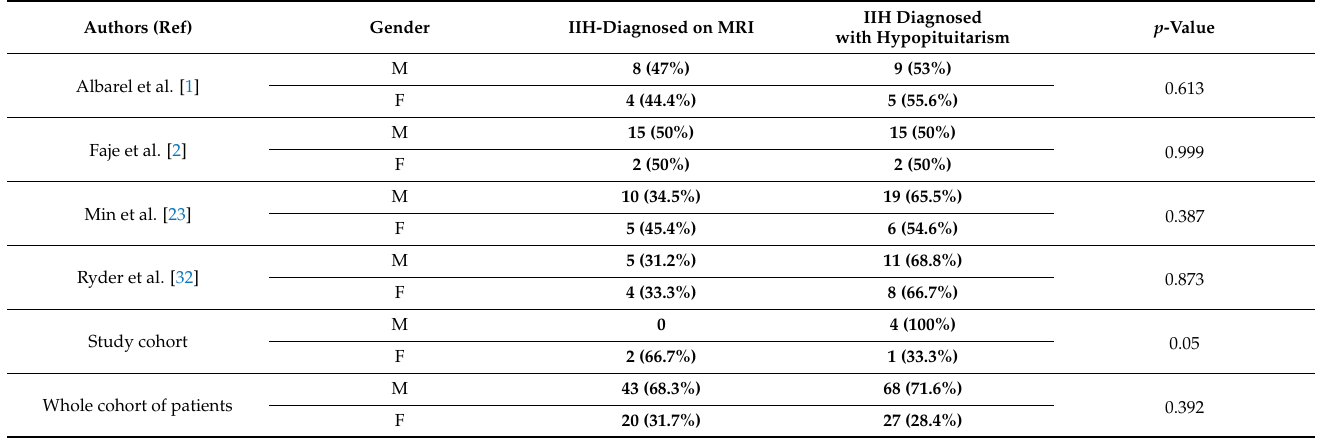
Table 3. Gender differences in IIH and ICI-induced hypopituitarism. Descriptive statistical analyses included absolute and relative frequencies for qualitative variables. Chi-squared test was applied for univariate